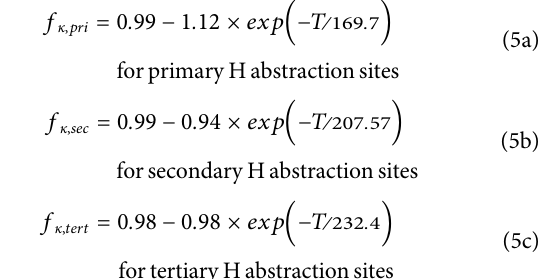
Frontiers in Chemistry |